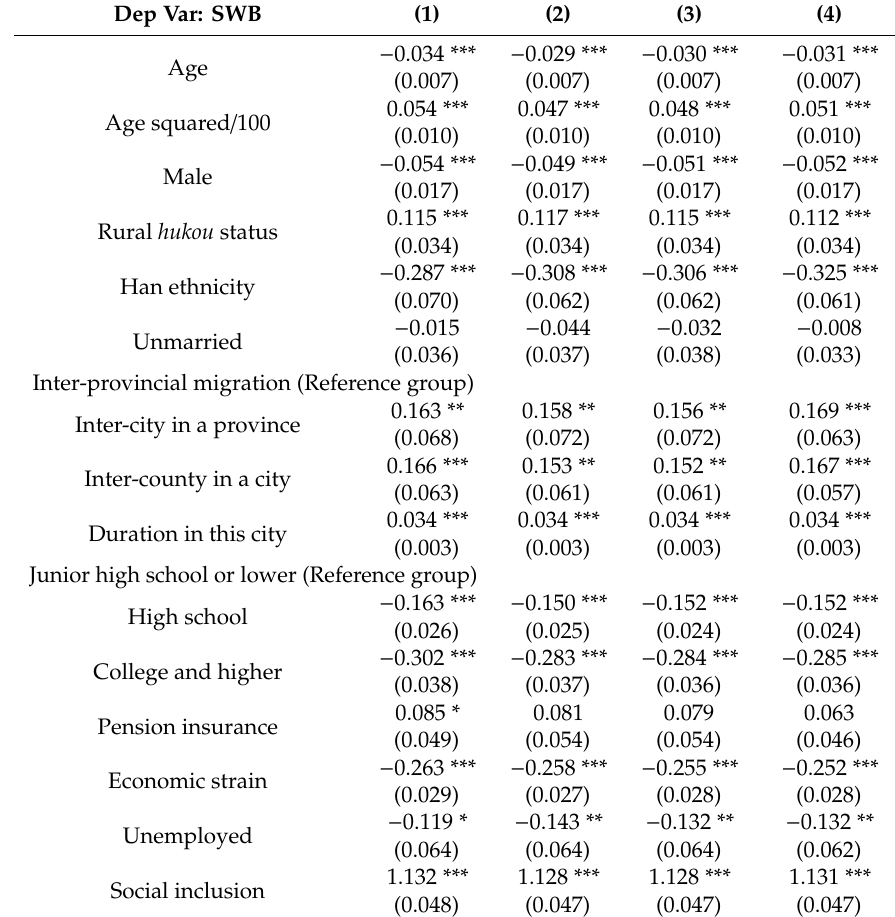
Table A5. The results of the omitted controls in Table